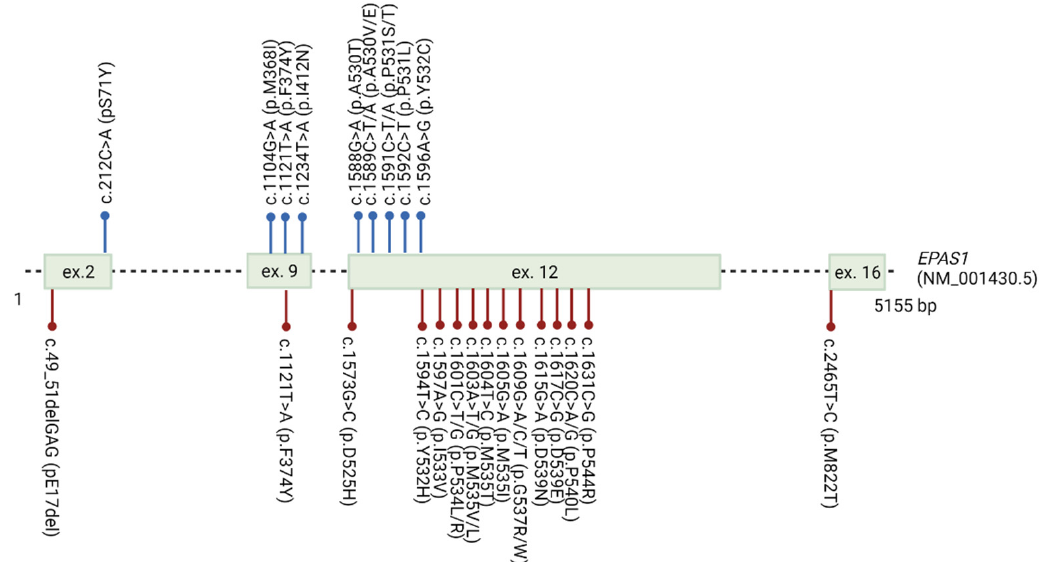
Figure 7. EPAS1 variants detected in association with paraganglioma/pheochromocytoma and familial erythrocytosis ECYT4. Blue dots indicate somatic variants detected in patients with paraganglioma/pheochromocytoma. Red dots indicate germline variants detected in patients with ECYT4.